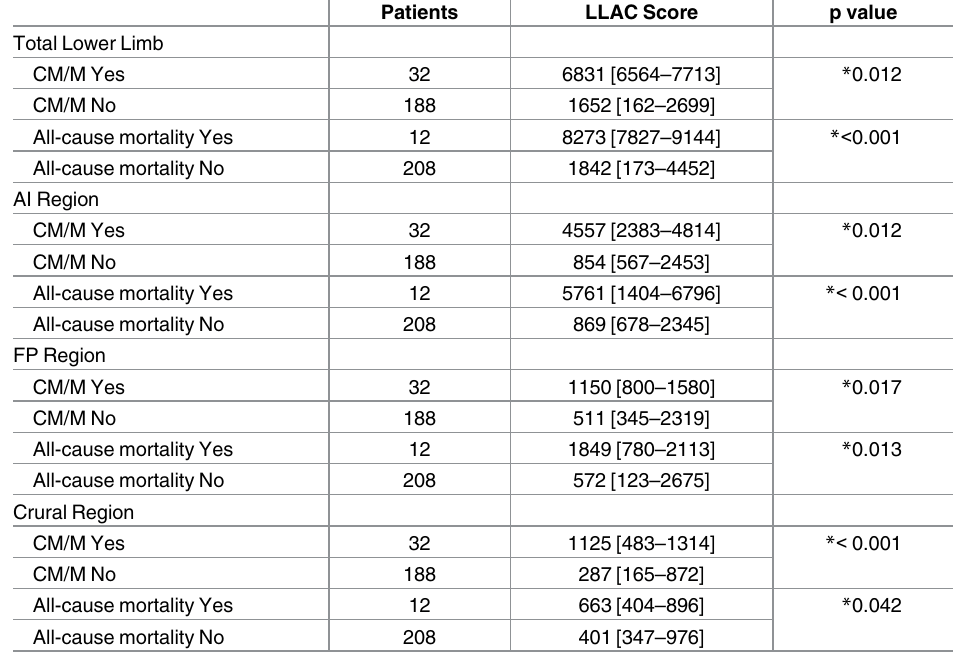
Table 3. Total and segments LLAC scores in patients with and without cardiovascular events during